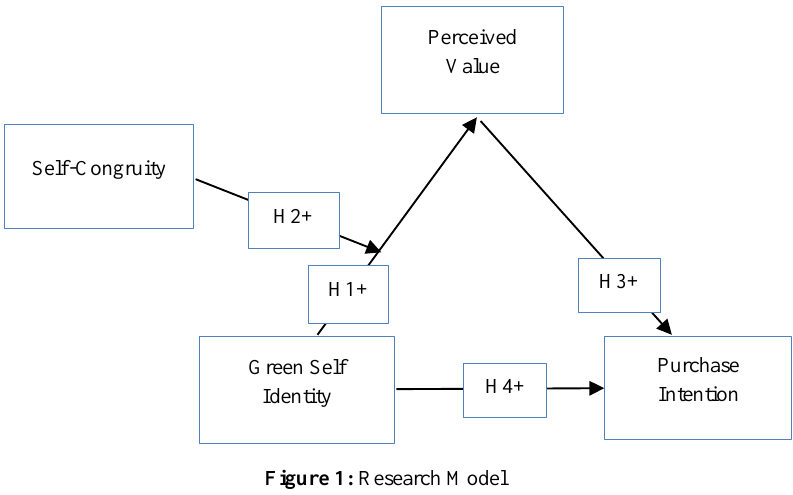
Figure 1: Research Model